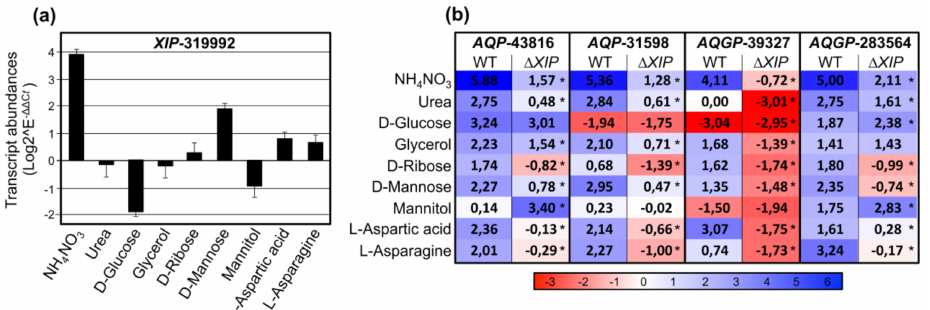
Figure 6. Relative transcription ratios of the expressed MIP genes from Trichoderma atroviride wild type and the five ∆ Triat XIP mutant upon growth on PDA medium supplemented with various inorganic and organic compounds. ( a ) Differential XIP transcript accumulation in the wild strain. ( b ) Differential AQP and AQGP transcript accumulation in the wild type and the five ∆ Triat XIP mutants. Differential transcript levels for each gene were estimated using real-time qRT-PCR analyses, and normalized by the expression of five housekeeping genes. Relative transcript abundance rates were obtained by the E - ∆∆ C t method. Data correspond to means of three biological replicates for the wild strain and the mean of the five ∆ Triat XIP mutants. Bars represent the biological standard error. *, Data are statistically significantly different between the wild and the five ∆ Triat XIP strains, as verified by one-way ANOVA analysis followed by Tukey’s post hoc test (* p < 0.05). Expression levels are displayed by the depth of color, where red represents down-regulated regulations and blue denotes up-regulated regulations. Statistical analysis showing the significant difference between wild type and mutants is detailed in Figure